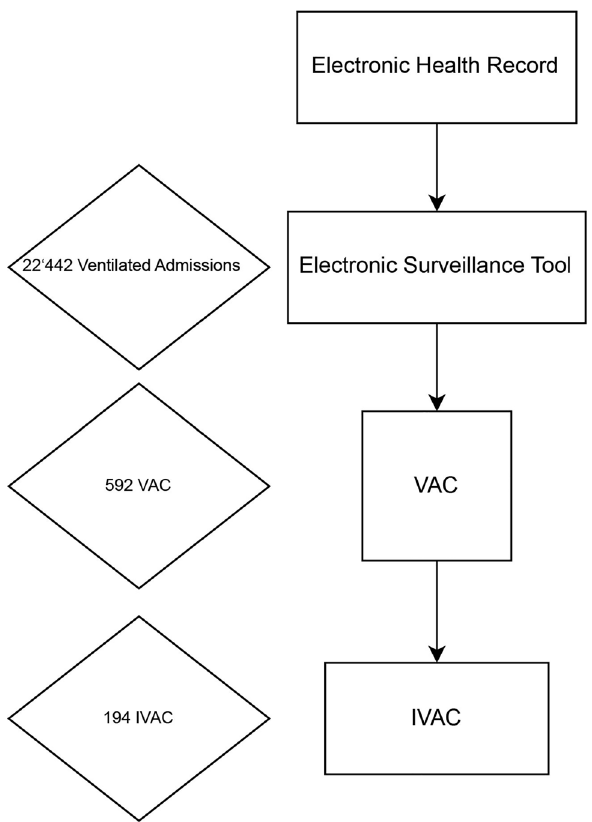
Figure 1. Flowchart showing information flow and information processing. VAC Ventilator associated condition; IVAC Infectious ventilator associated condition.